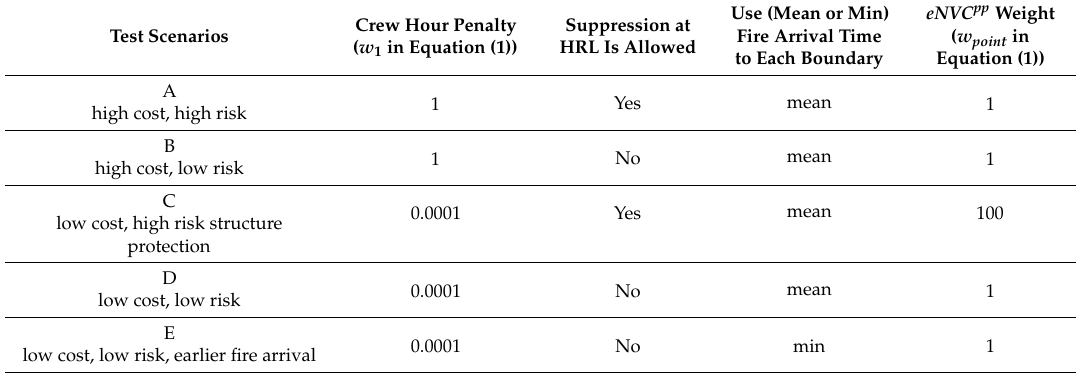
Table 3. Model parameters of five tested